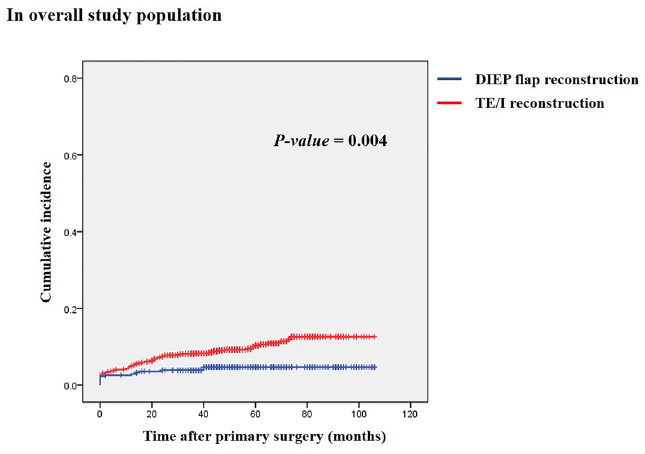
Figure 1. Comparison of cumulative incidence of major complications between the two groups using Kaplan– Meier